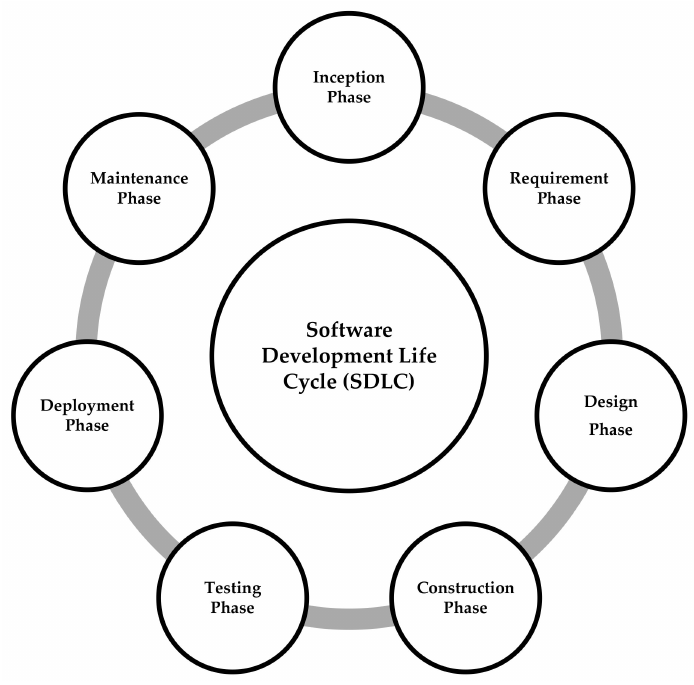
Figure 1. Software Development Life Cycle (SDLC)